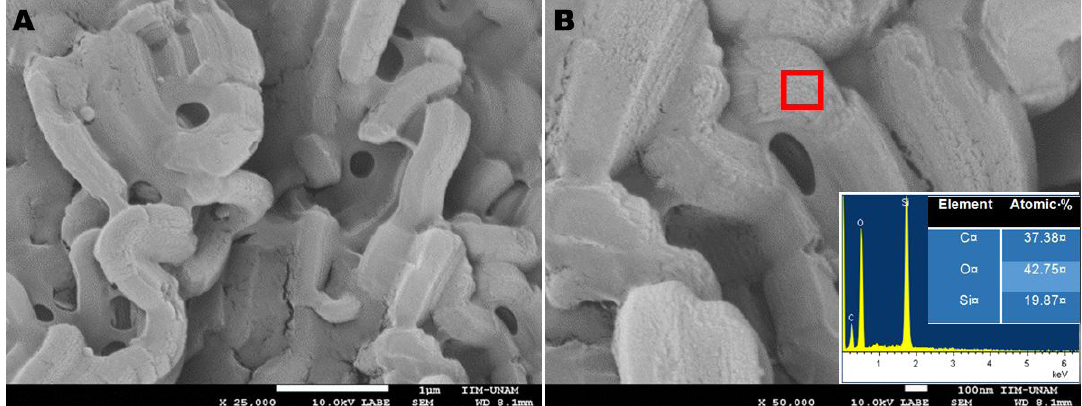
Figure 2. FE‑SEM images micrographs of SBA‑15 mesoporous ceramic material (A and B). The red box showed the area of the element analysis by EDS of carbon, oxygen, and silicon.